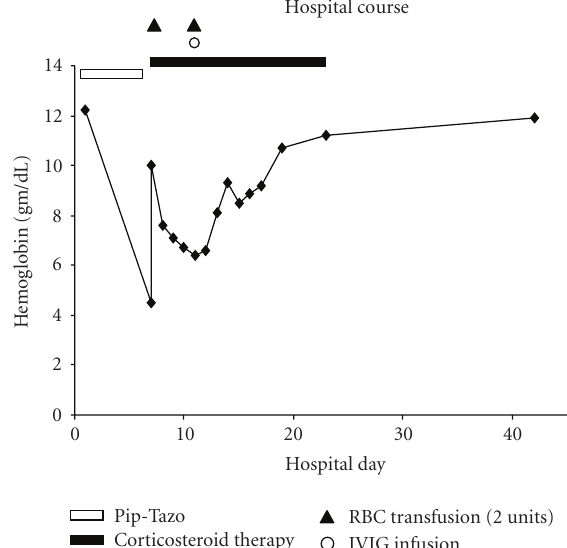
Figure 1: Hemoglobin profile over the hospital course. Timing of medical interventions is indicated by symbols (two units of packed red blood cells were given with each